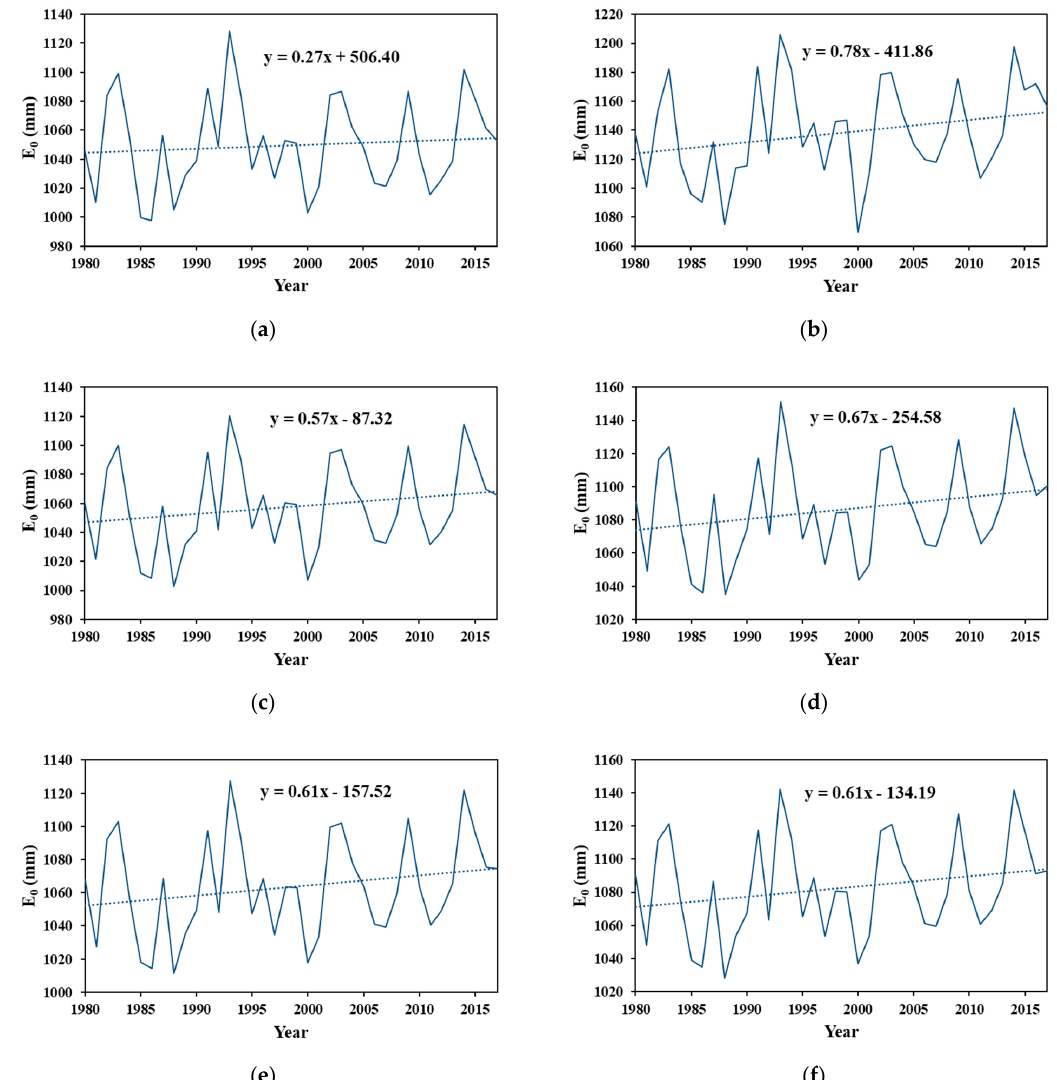
Figure 3. The trend of annual potential evapotranspiration in northern Taiwan during 1980~2017. ( a ) Lanyang River Basin. ( b ) Keelung River Basin. ( c ) Dahan River Basin. ( d ) Fengshan River Basin. ( e ) Youluo River Basin. ( f ) Shangping River Basin.